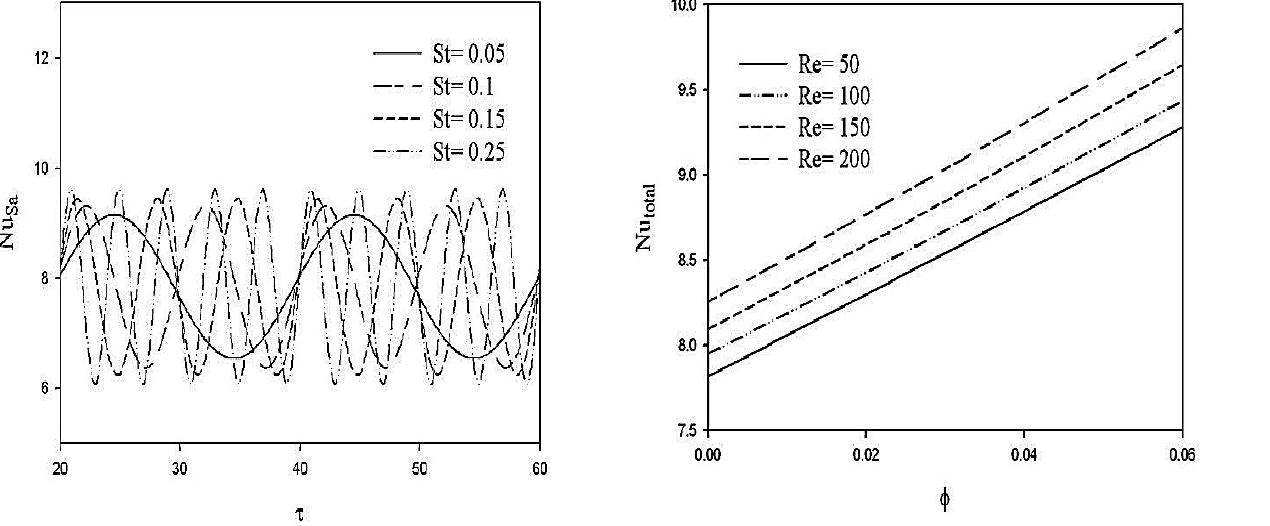
Fig. 7. Space averaged Nusselt number for different Strouhal Number and constant conditions Re=100, =0.15. 0.0 φ = and A 0